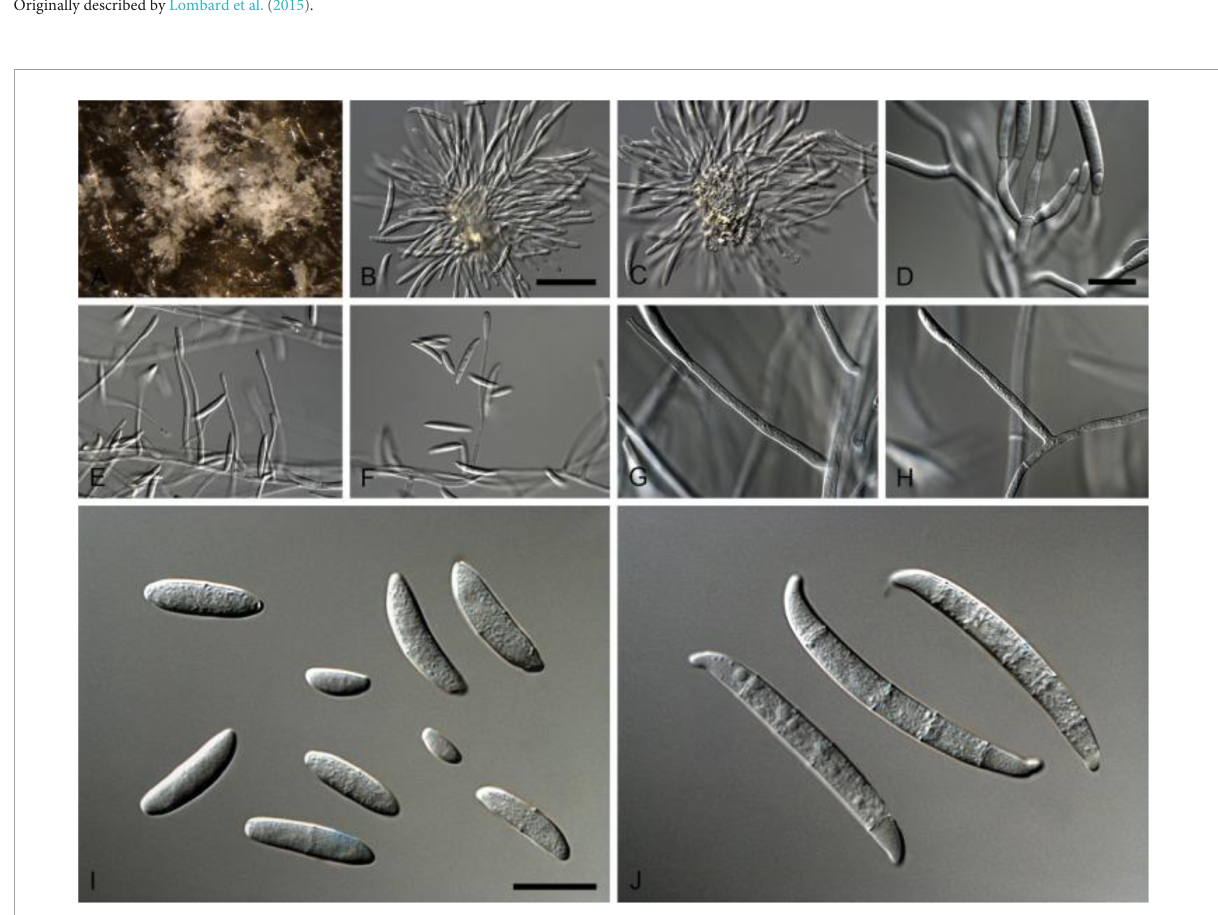
FIGURE1 Neocosmospora rubicola (ex-type CBS 101018). (A–C) Sporodochial conidiophores. (D) Conidiogenous apparatus with cylindrical to allantoid phialides. (E–H) Simple conidiophores. (I) Microconidia. (J) Macroconidia. Scale bars: (B) 50 µ m [apply to (C,E,F) ]; (D) 10 µ m [apply to (G–H) ]; (I) 10 µ m [apply to (J) ]. Adapted from Lombard et al.